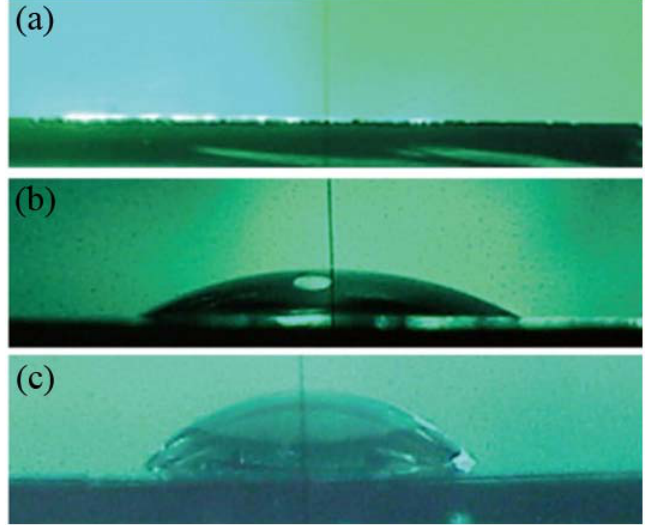
Figure 2. Water drops on chemically oxidized SiO (WCA < 5°); ( b ) annealed at 700°C for 10 min (WCA = 24°); and ( c ) annealed at 700 °C for 60 min (WCA = 67°). Reproduced with modification from [25] by permission of the PCCP Owner